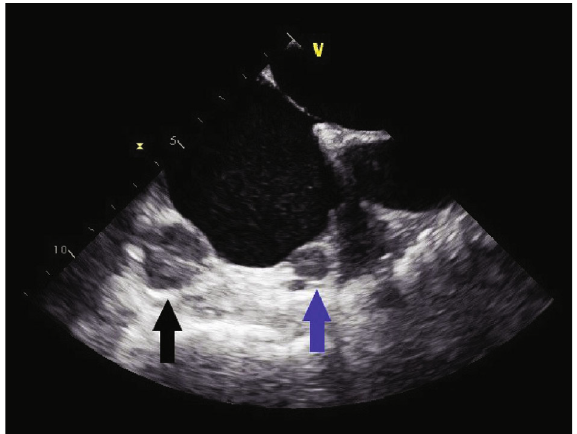
Figure 2: TEE horizontal view: right atrial masses in the area of the tricuspid valve and atrioventricular groove (blue arrow) and in the area of the atrioventricular groove (black